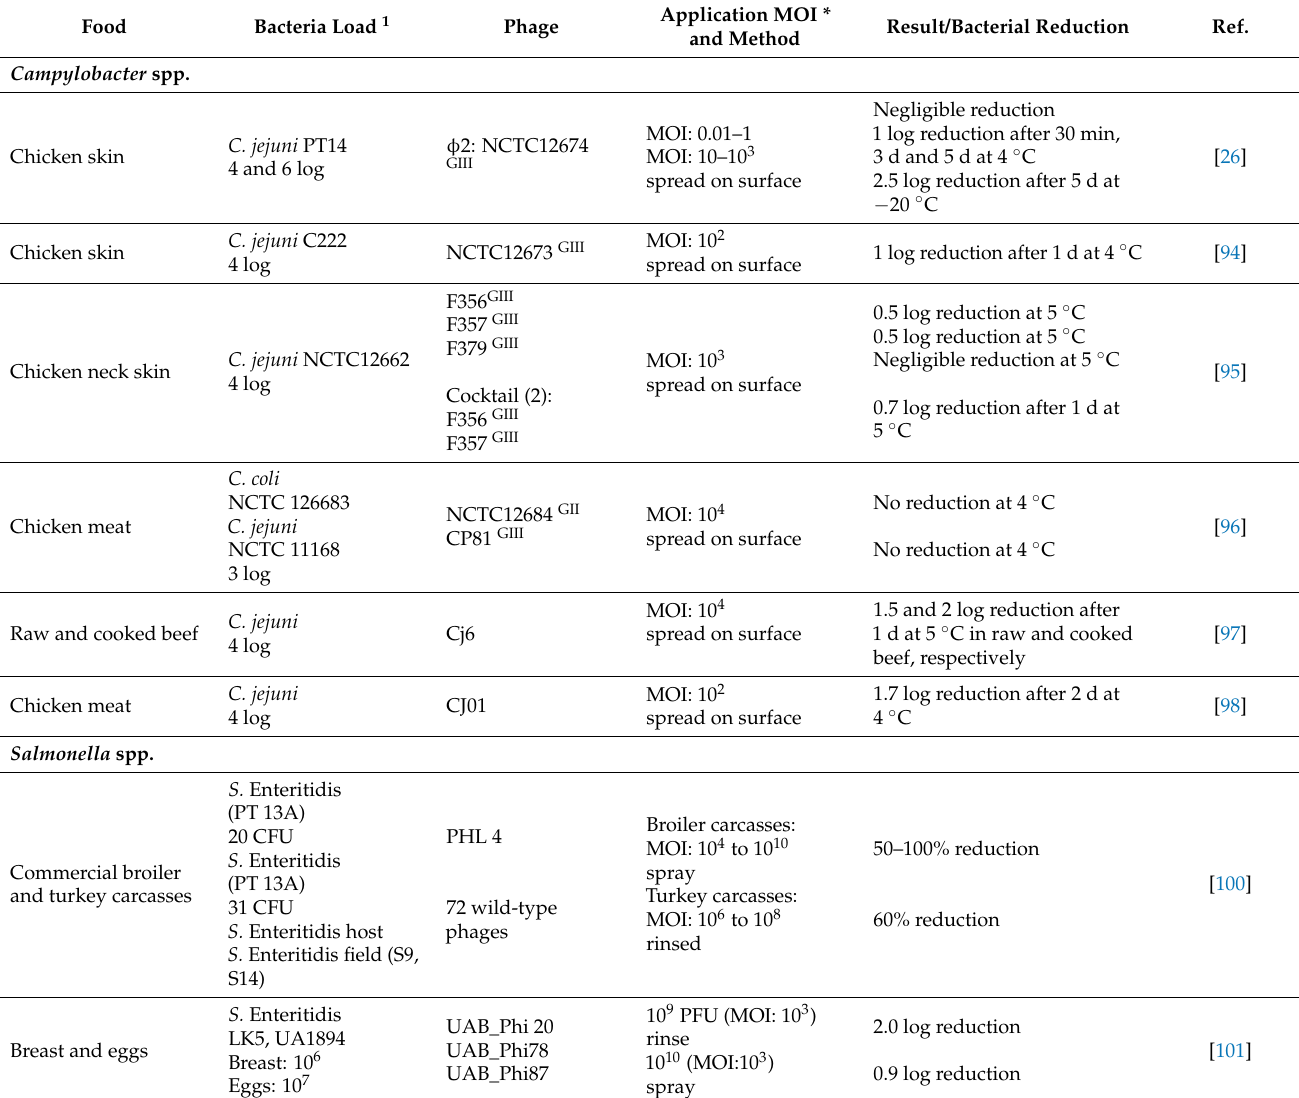
Table 3. Examples of the effectiveness of phage biocontrol of target foodborne pathogens on different food